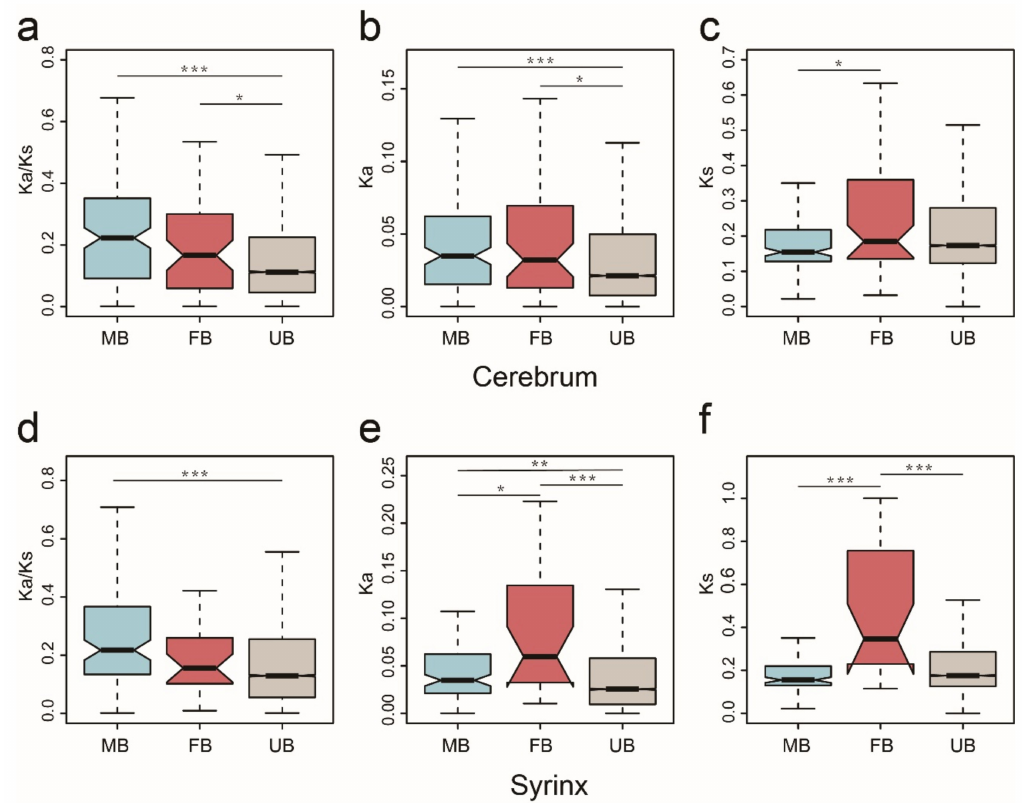
Figure 4. The rates of divergence of sex-biased genes and unbiased genes in hwamei cerebrum and syrinx. Boxplots show the Ka/Ks (cerebrum ( a ); syrinx ( d )), Ka (cerebrum ( b ); syrinx ( e )) and Ks (cerebrum ( c ); syrinx ( f )) distribution trait for the male-biased genes (MB), female-biased genes (FB) and unbiased genes (UB) in the cerebrum and syrinx tissues. Significant difference is represented by *, using Wilcoxon rank sum test, * p < 0.05, ** p < 0.01, *** p < 0.001.